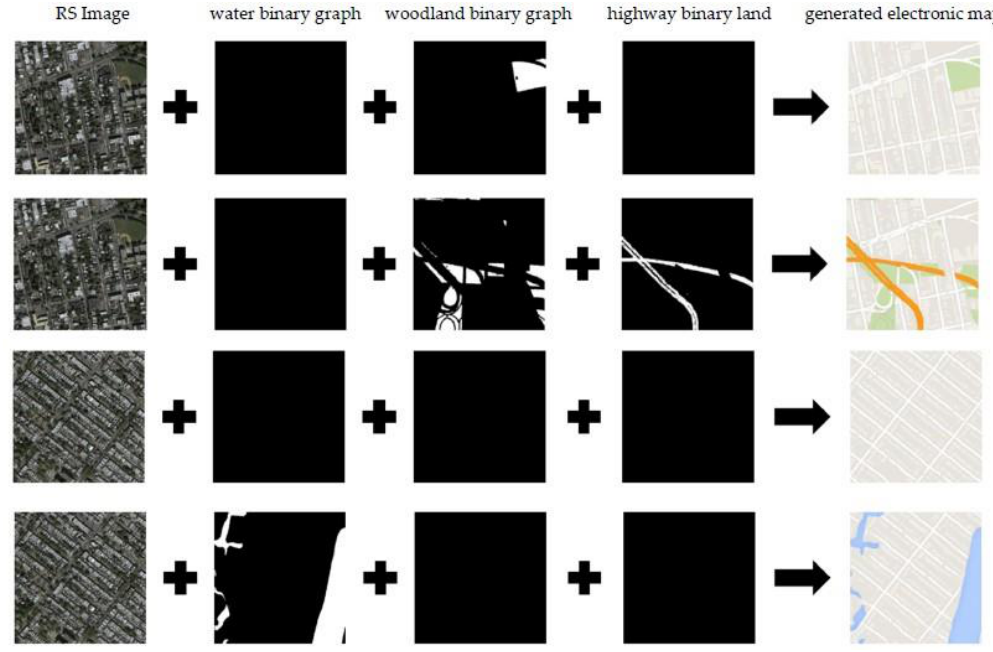
Figure 8. Test for the influence of three binary graph channels in model input on color rendering of the generated electronic map. RS image: remote sensing image. The middle three columns are binary maps corresponding to different elements.